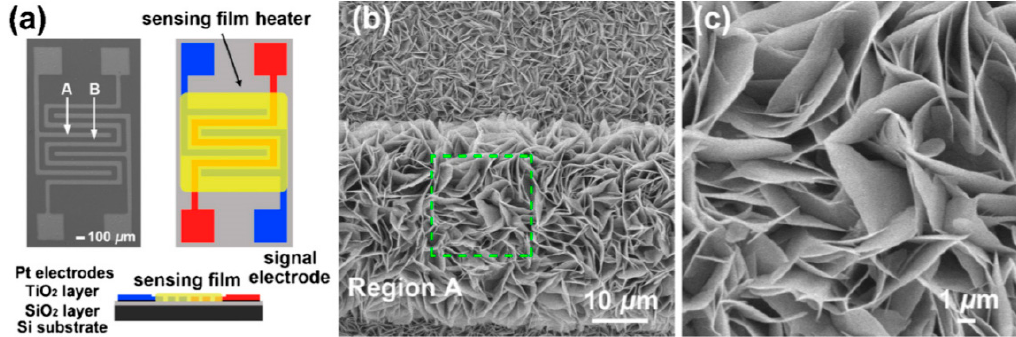
Figure 40. ( a ) Schematic diagrams of the different views for the microstructure sensor. Morphologies and crystal structures of ZnO nanosheets (NSs): ( b , c ) FESEM images of ZnO NSs taken from different regions in the microstructure sensor. Reproduced with permission from Zeng et al. [363]. Copyright 2012: Elsevier.